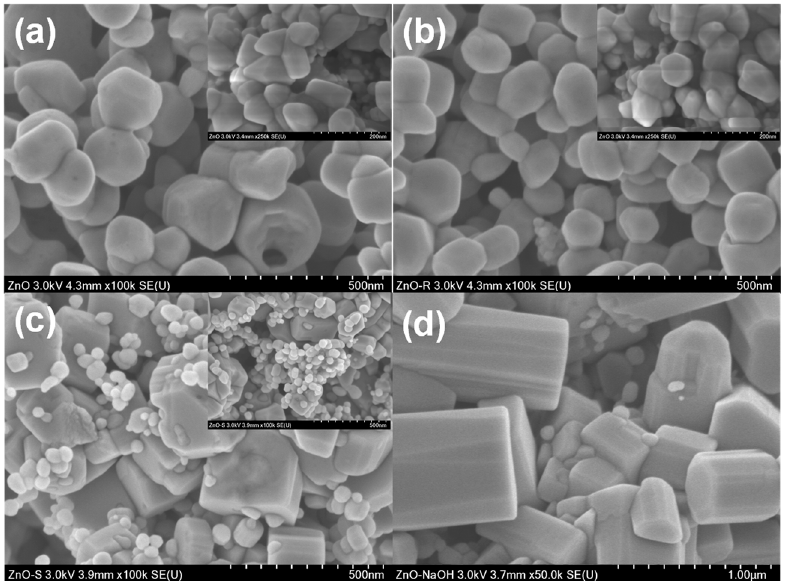
Figure 5. SEM analysis of the ZnO NPs obtained at different conditions: ( a ) ZnO-UA, ( b ) ZnO-MS, ( c ) ZnO-RC, and ( d ) ZnO-NS.